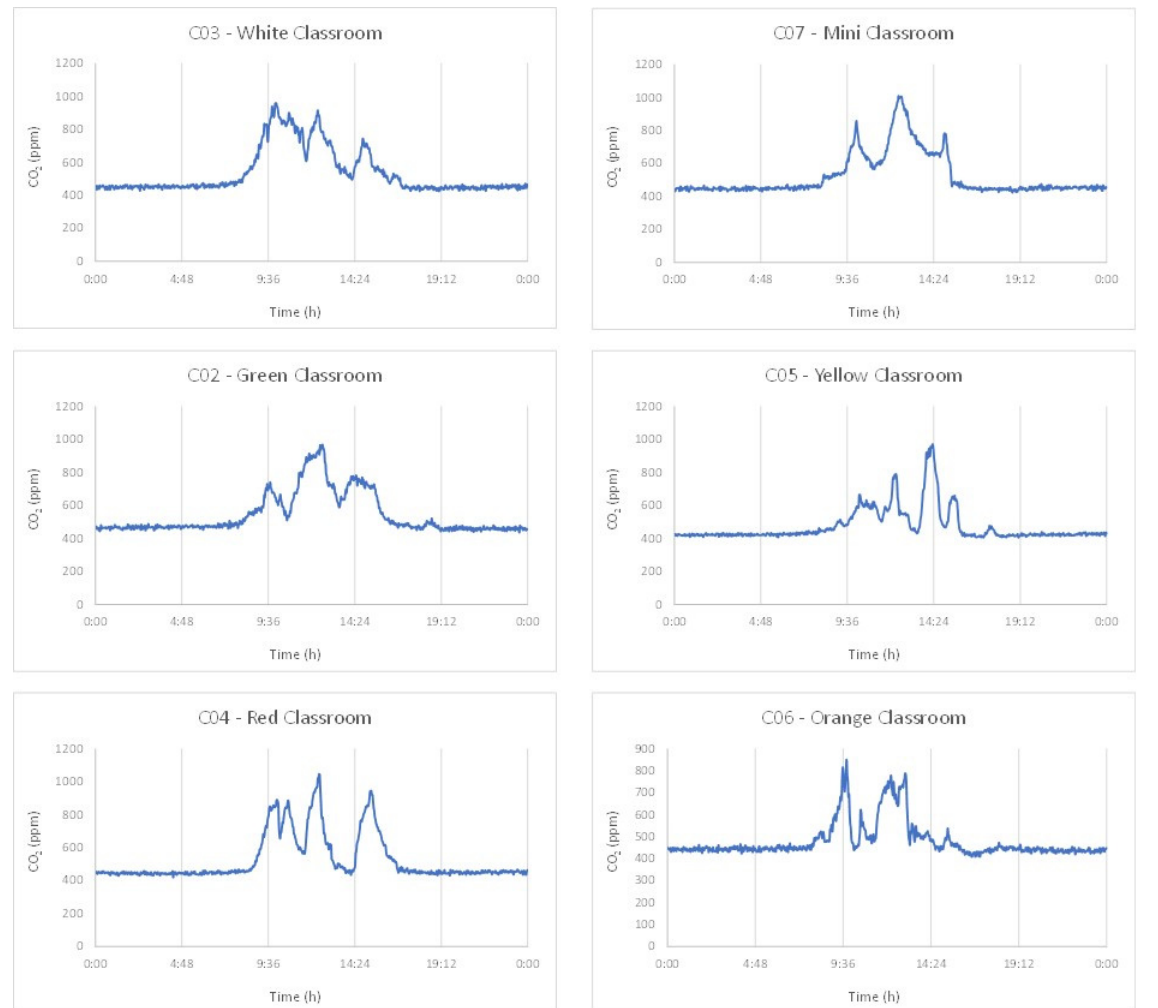
Figure 3. CO 2 trends in the classrooms at Immacolata (permanent sensors).